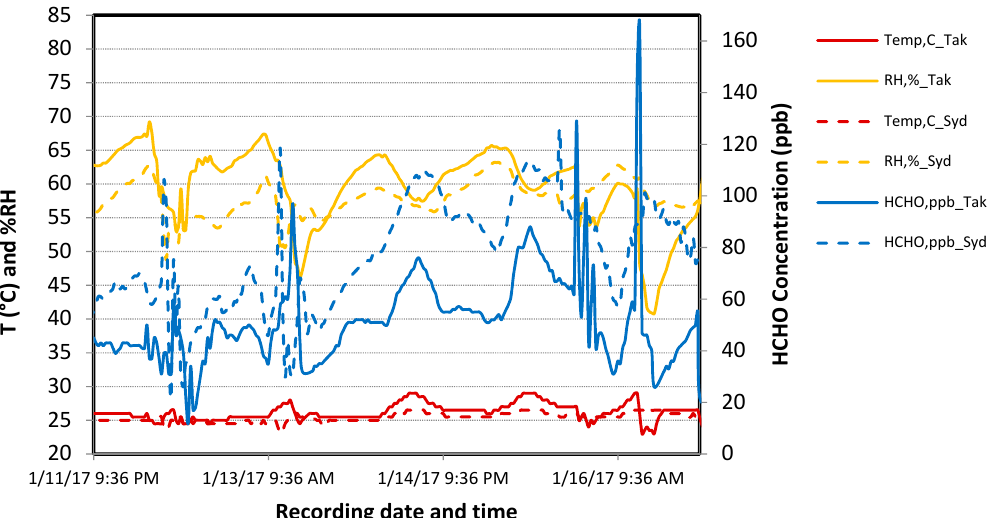
Figure 12. Comparative T, RH, and HCHO concentrations in Sydney and Takshasila.